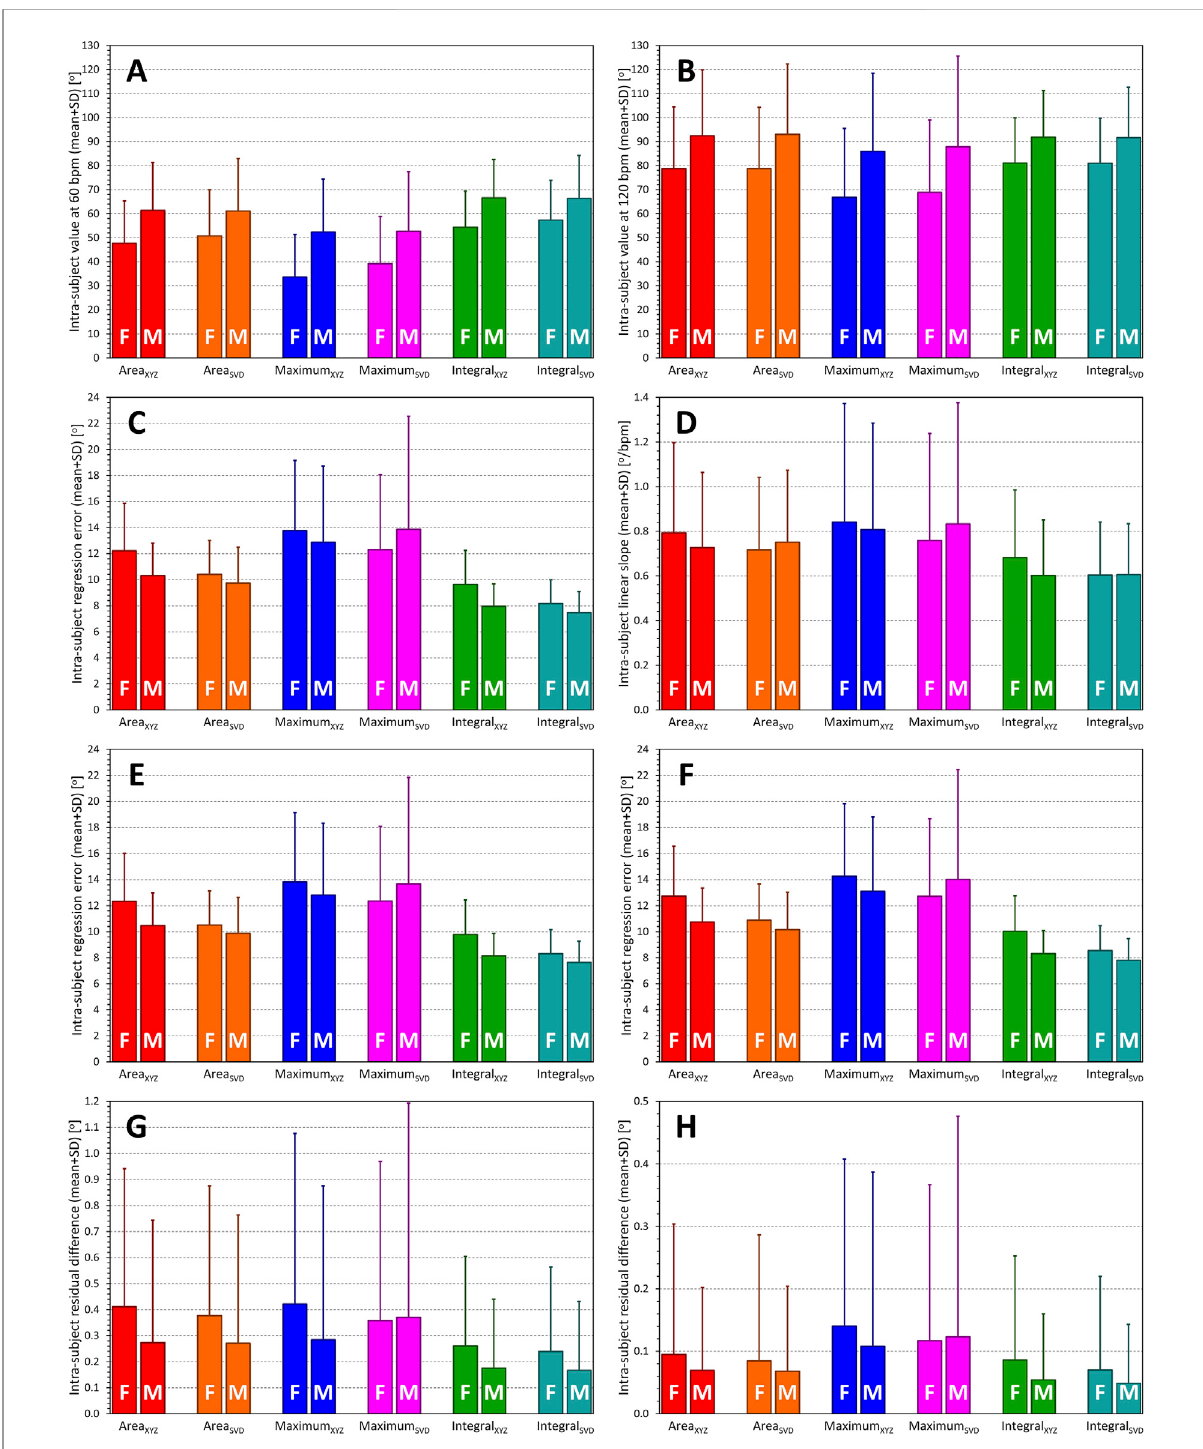
FIGURE 11 Summaries of QRS-T angle/rate regression residuals. Statistical evaluation of the characteristics of different QRS-T angle expressions (see the labels of the horizontal axes in each panel). Panels (A,B) show the intra-subject QRS-T angle values measured at the heart rate of 60 and 120 bpm, respectively (as derived by the second-degree polynomial regressions between QRS-T angle measurements and heart rate measured over the preceding 1 min). Panel (C) shows intra-subject residuals of the second-degree polynomial regression between QRS-T angle measurements and heart rate expressed by intra-subject optimum hysteresis model. Panel (D) shows intra-subject slopes of linear regressions between QRS-T angle measurements and heart rate measured during the preceding 1 min. Panels (E,F) show the intra-subject residuals of